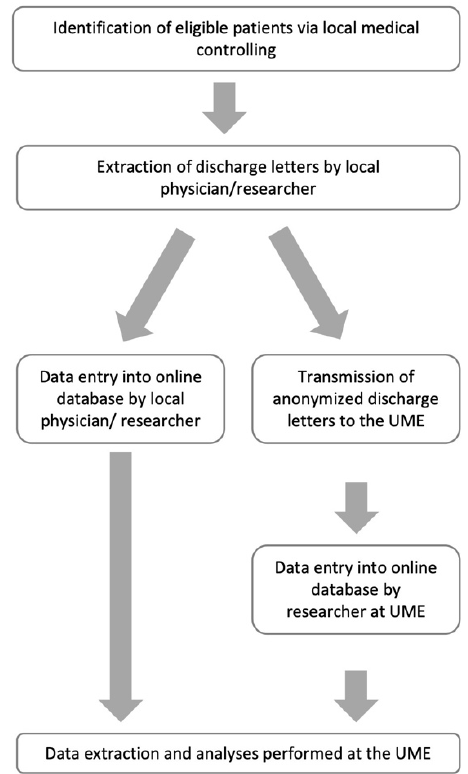
Figure 1. Data flow between participating centers. UME, University Medicine Essen.